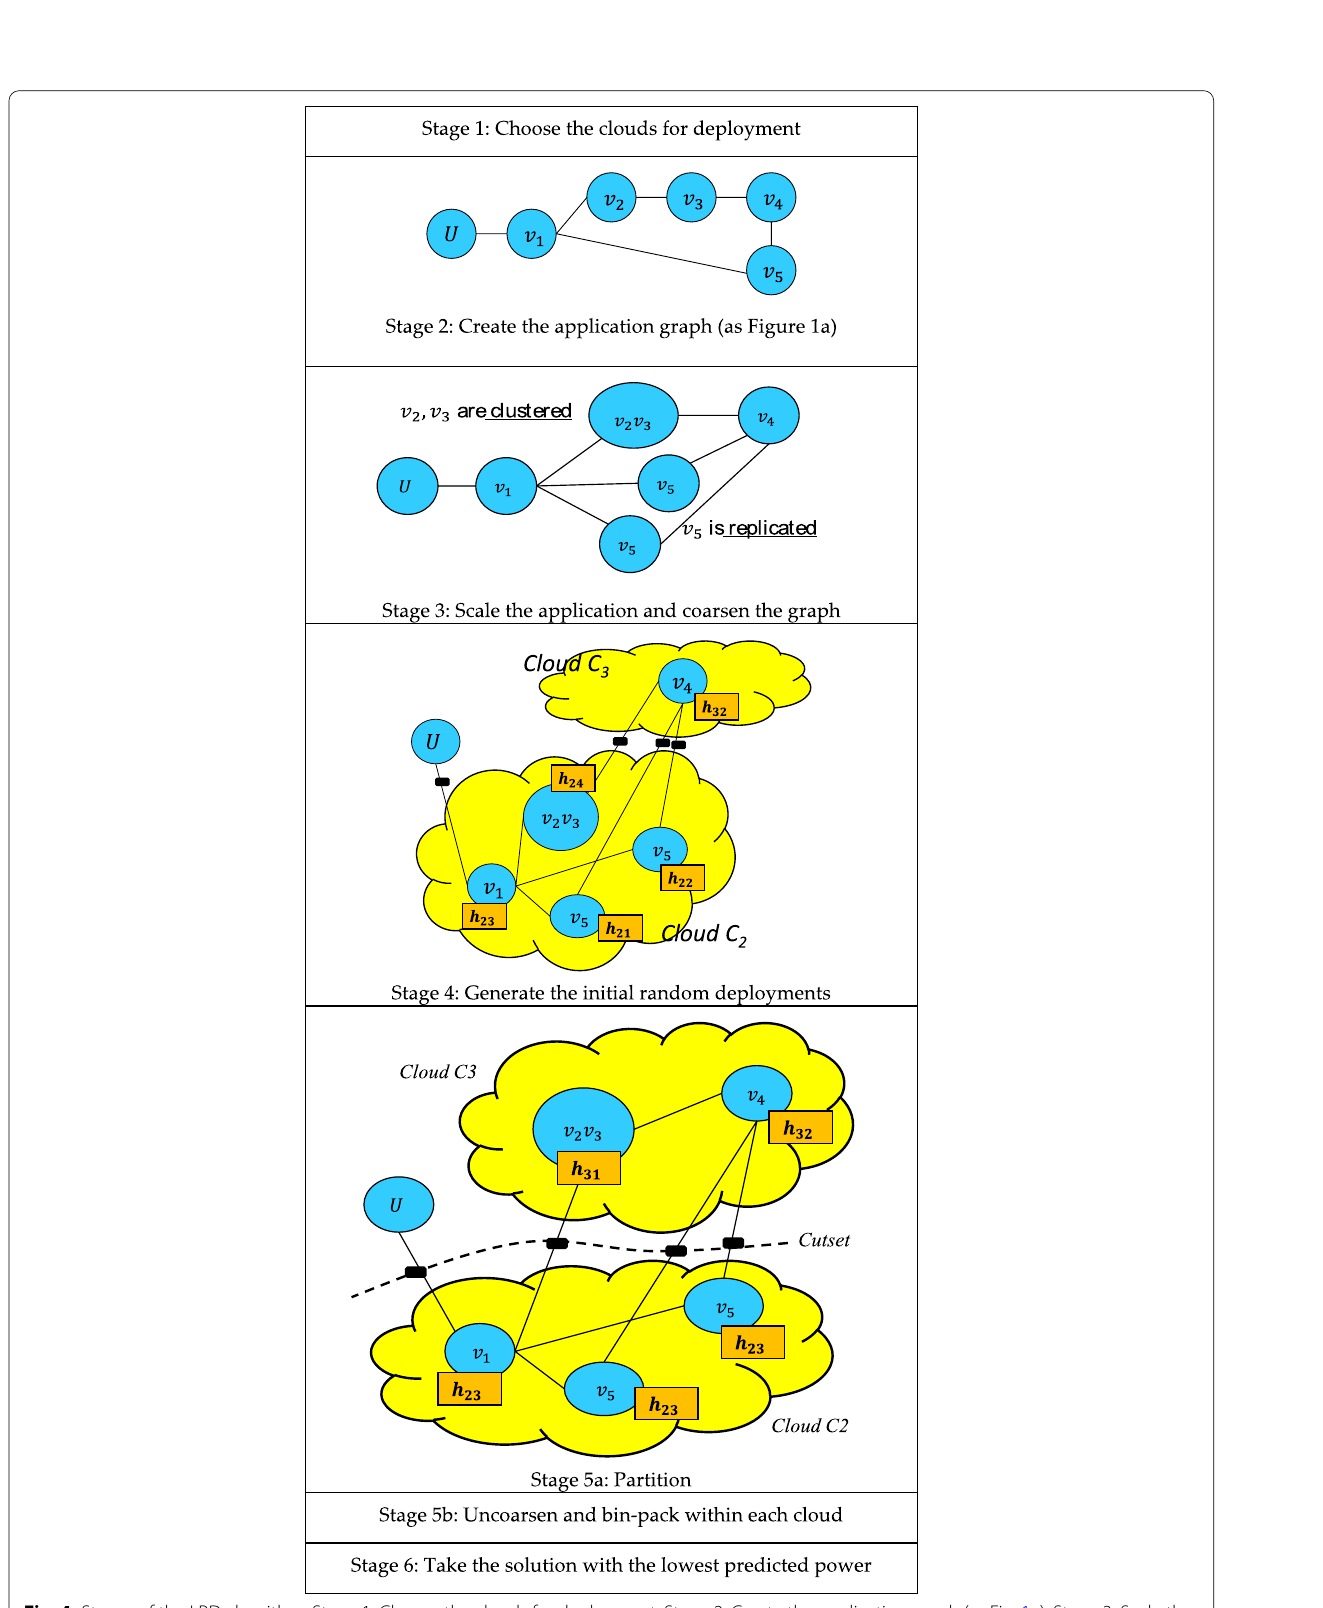
Fig. 4 Stages of the LPD algorithm. Stage 1: Choose the clouds for deployment. Stage 2: Create the application graph (as Fig. 1a). Stage 3: Scale the application and coarsen the graph. Stage 4: Generate the initial random deployments. Stage 5a: Partition. Stage 5b: Uncoarsen and bin-pack within each cloud. Stage 6: Take the solution with the lowest predicted